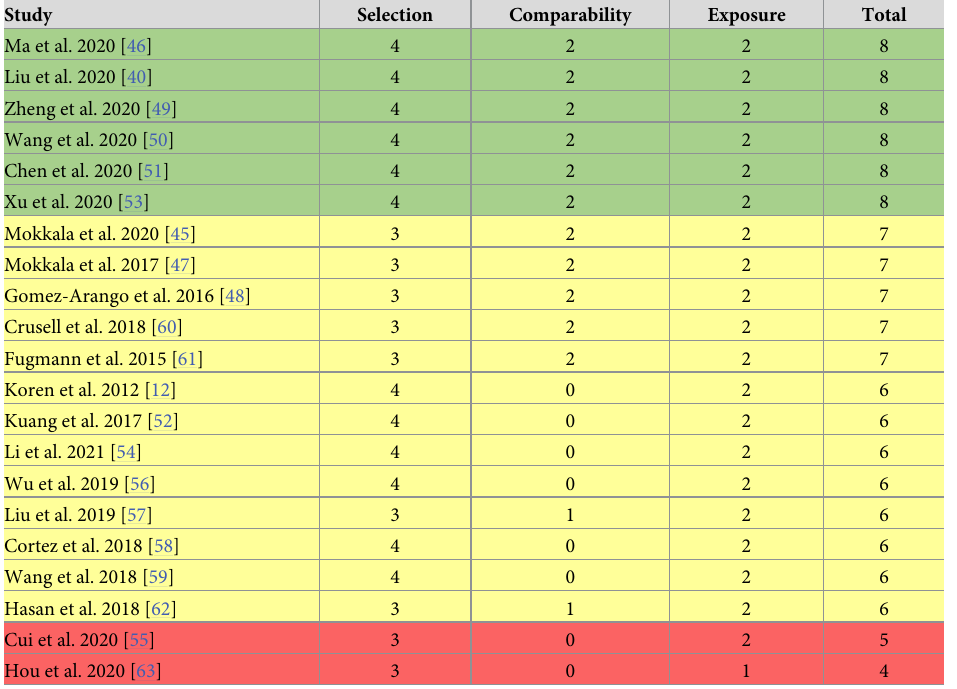
Table 6. Quality assessment of included studies based on the Newcastle–Ottawa Scale for case-control